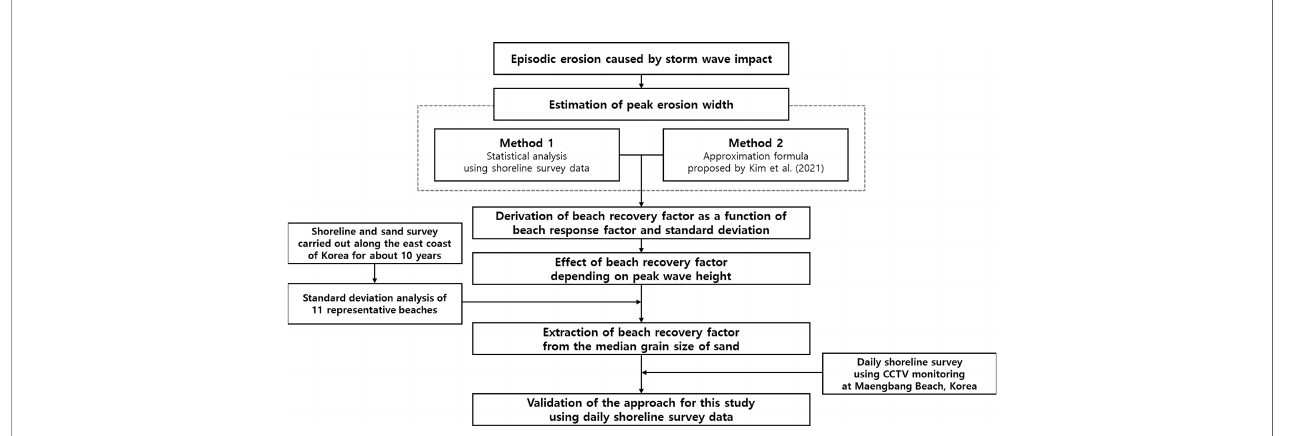
FIGURE 1 | Process showing how the research is conducted to extract the beach recovery